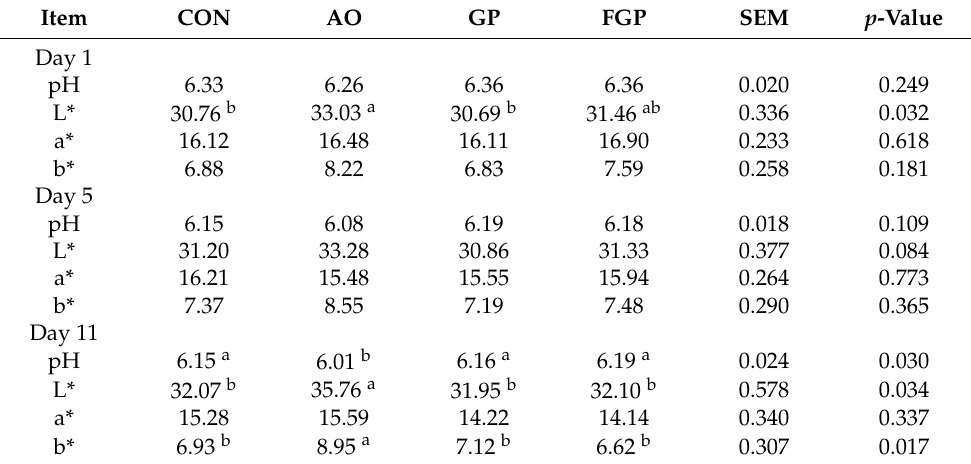
Table 4. Liver quality parameters of broiler chickens fed diets containing raw grape pomace, fer- mented grape pomace, and synthetic antioxidants 1